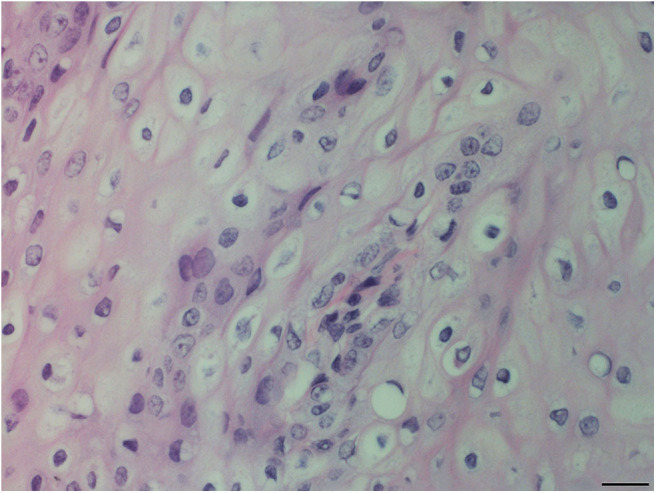
Oropharyngeal mucosal plaque, rough-toothed dolphin (case R305). Hyperplastic epithelial cells with pale foamy cytoplasm. Epithelial cells have clear perinuclear cytoplasmic halos or vacuolation with pyknotic or hyperchromatic displaced nuclei (HE). Obj. 40x. Bar = 20 μm.